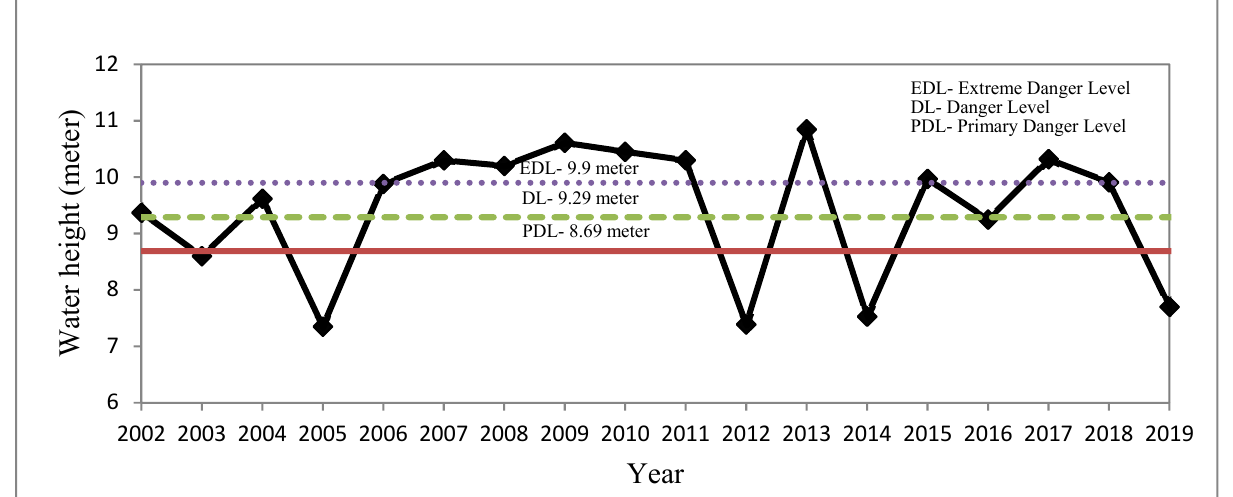
Figure 6. Highest gauge height in New Cossye river at Panskura rain gauge station